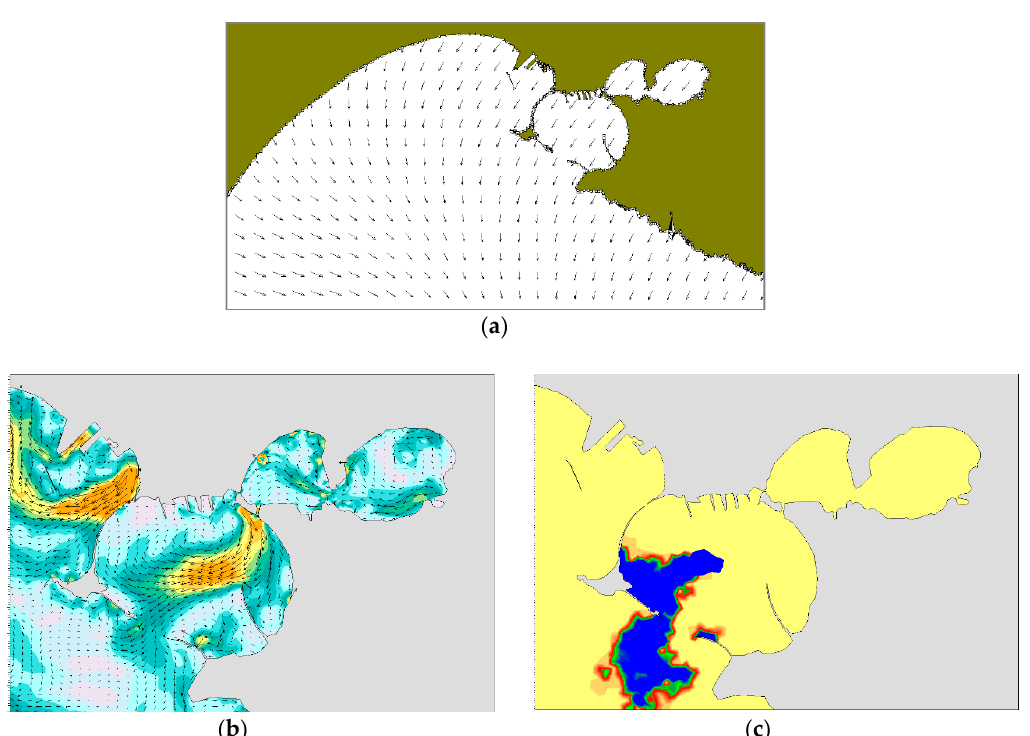
Figure 10. Test T1. Dec. 13, at 18:00. ( a ) Model wind fields; (b) Surface currents; (c) Oil slicks. Legends as in Figure 9.